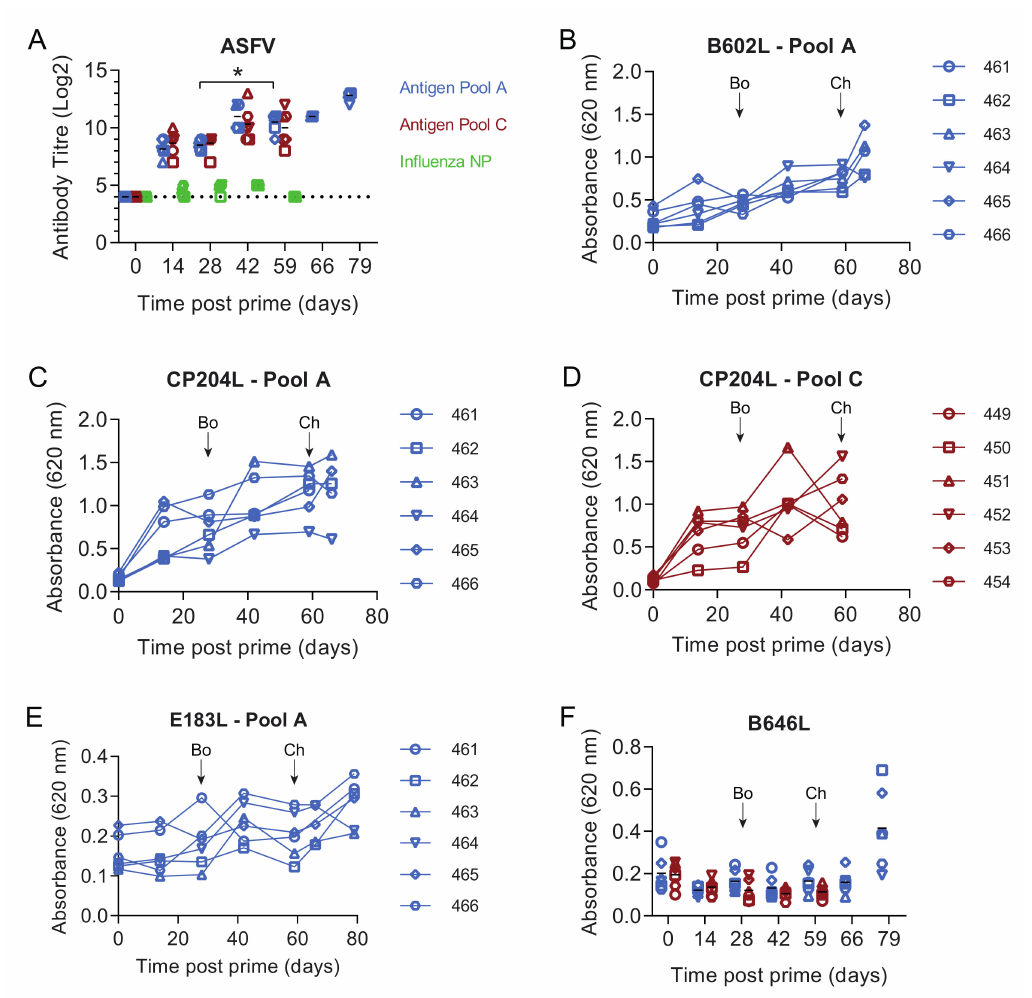
Figure 5. Antibody responses in pigs from experiment 2 primed with rAd encoding Antigen Pool A (blue), Antigen Pool C (red) or influenza NP. Animals were boosted with rAd / MVA 28 days after priming and challenged with ASFV 59 days after priming. ( A ) The titre of anti-ASFV antibodies in the serum of the indicated animals was determined by immunoperoxidase assay. Antibodies to ASFV proteins B602L ( B ), CP204L ( C , D ), E183L ( E ) and B646L ( F ) were detected in 1:100 dilutions of serum collected from the indicated animals at the indicated times post-prime by ELISA, and expressed as the absorbency at 620 nm. Timing of boost (Bo) and challenge (Ch) are indicated on panels B to F. Data points on panel F represent values from individual animals and are labelled as on panels D (Antigen Pool C) and E (Antigen Pool A). Di ff erences between antibody titres were assessed by repeated-measures two-way ANOVA,* p ≤